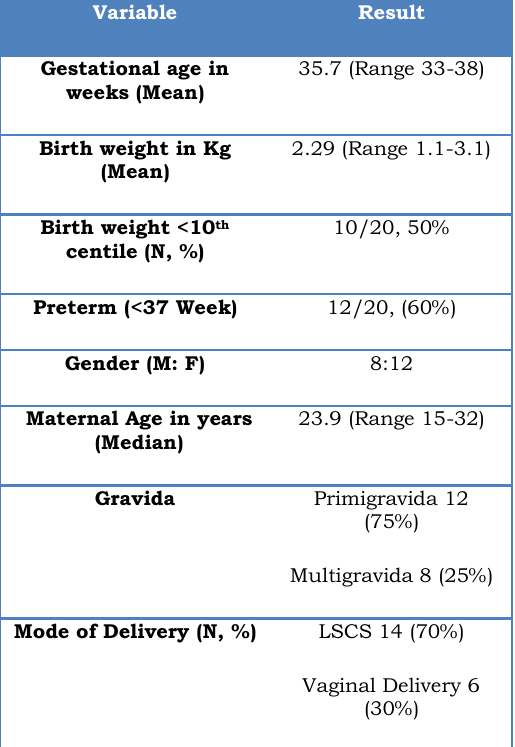
Table 1: Demographics of the study